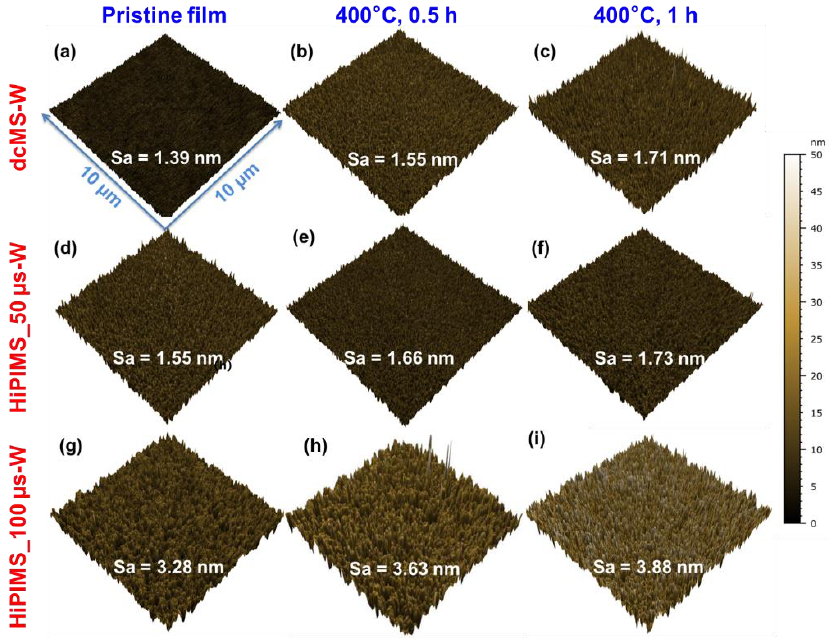
Figure 10. AFM morphologies and roughness (Sa) of W thin film surface after vacuum annealing at 400 °C for 0.5 and 1 h. (a) Pristine, (b) 400 °C/0.5 h, and (c) 400 °C/1 h annealed W films deposited by dcMS. (d) Pristine, (e) 400 °C/0.5 h, and (f) 400 °C/1 h annealed W films deposited by HiPIMS with pulse length of 50 μs . (g) Pristine, (h) 400 °C/0.5 h, and (i) 400 °C/1 h annealed W films deposited by HiPIMS with pulse length of 100 μs .